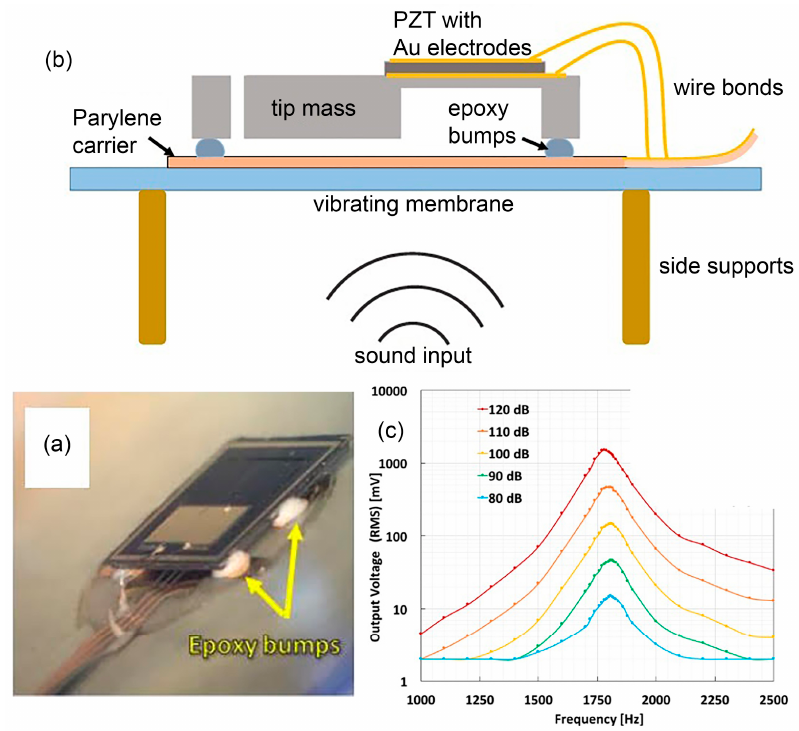
Figure 3. ( a ) Side view of a MEMS acoustic energy harvester chip attached on a carrier with epoxy bumps. ( b ) The schematic view of the piezoelectric transducer on the ear drum mimicking membrane. ( c ) Measured frequency sweep results of the prototype chip. Modified from [46].